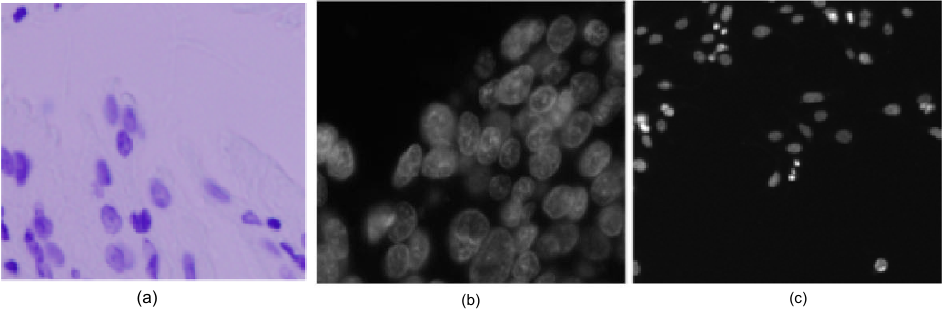
Figure 1. Diversity within the original images: ( a ) heterogeneous illumination. ( b ) Boundaries between the nucleus are ambiguous. ( c ) Microscope magnification and variety of cell